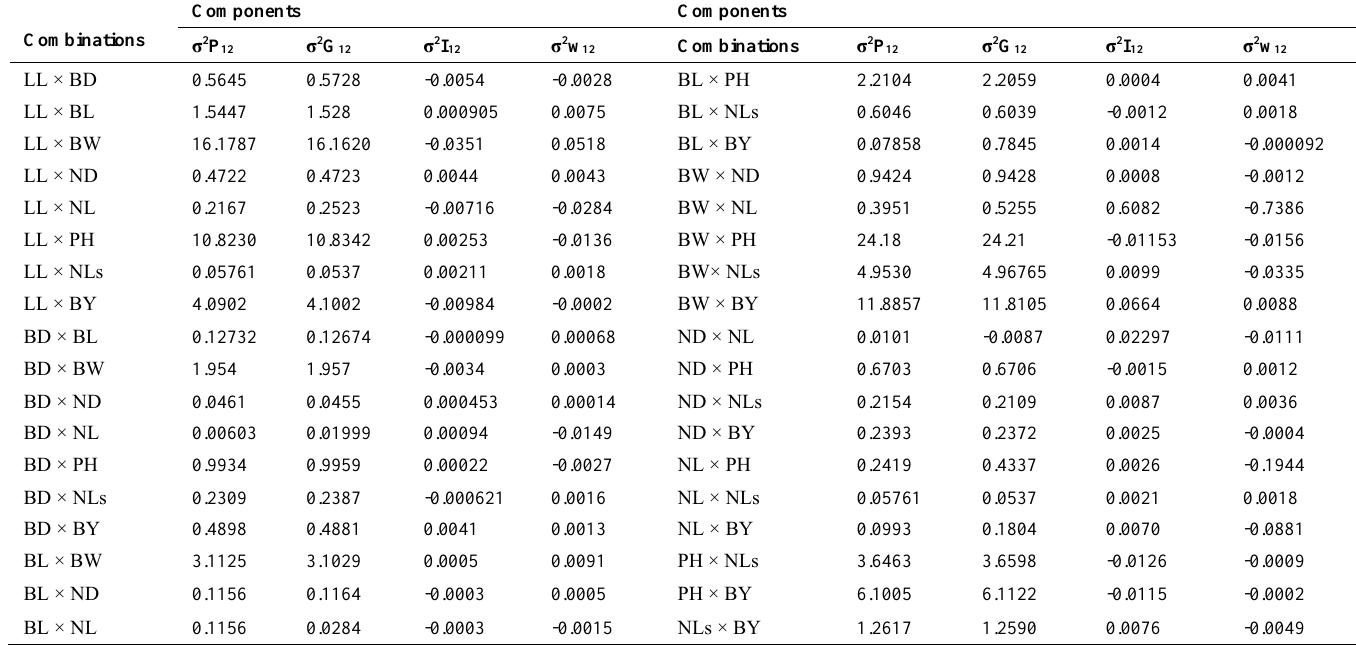
Table 2 . Values of phenotypic (σ 2 P 12 ), genotypic (σ 2 G 12 ), interaction (σ 2 I 12 ) and within error (σ 2 w 12 ) components of covariation of all possible pairs for nine characters in onion